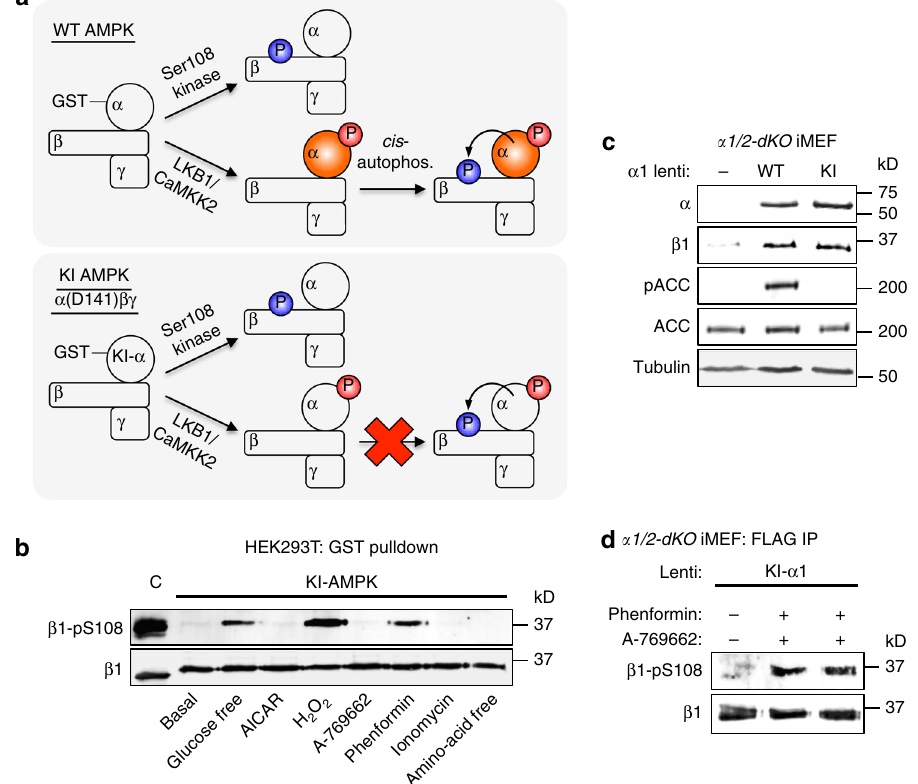
Fig. 3 β 1-Ser108 trans -phosphorylation occurs via an AMPK independent mechanism. a Rationale for employing kinase inactive (KI) AMPK to examine cellular Ser108 phosphorylation. β 1-Ser108 phosphorylation ( blue ) can potentially be performed by an upstream kinase in both WT and KI α 1(D141A) AMPK mutant. LKB1/CaMKK2-mediated phosphorylation of α -Thr172 ( red ) activates WT AMPK ( orange ) leading to background Ser108 cis -autophosphorylation. This is excluded using KI AMPK, which can be phosphorylated on Thr172 but remains inactive. b Immunoblot for β 1-pSer108 in KI- α 1 β 1 γ 1 puri fi ed from HEK293T cells treated with AMPK-activating agents/conditions: glucose free (glucose-free DMEM + 10% serum, 4 h), AICAR (2 mM, 1 h), H 2 O 2 (1 mM, 45 min), A-769662 (300 μ M, 1 h), phenformin (2 mM, 1 h), ionomycin (2.5 μ M, 15 min) and amino-acid free (EBSS medium, 4 h). n = 3, representative immunoblots shown. C: Bacterial expressed, CaMKK2-treated α 1 β 1 γ 1 standard. c Reconstitution of basal AMPK signaling in AMPK α 1/2 double knockout ( α 1/2-dKO ) iMEFs by lentiviral transduction of AMPK α 1 WT, but not the KI mutant. d Immunoblot for β 1-pSer108 from α 1/2-dKO iMEFs-expressing KI- α 1, stimulated with 2 mM phenformin for 1 h. n = 3, representative immunoblots